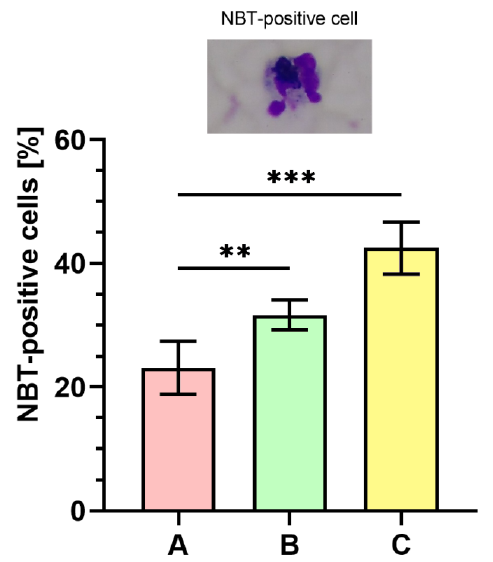
Figure 7. Percentages of nitroblue tetrazolium (NBT)-positive cells. A—Mueller-Hinton agar non-supplemented (MHA, control), B—MHA supplemented with 1% ( v / v ) Tween 80, and C—MHA supplemented with 1% ( v/v ) Tween 80 and trans -anethole at subinhibitory concentration (MIC 50 ). Photographic evidence is presented in the pictures above the graph (magnification: 400x). Data are shown as the mean ± SD. ** p < 0.01, *** p < 0.001.